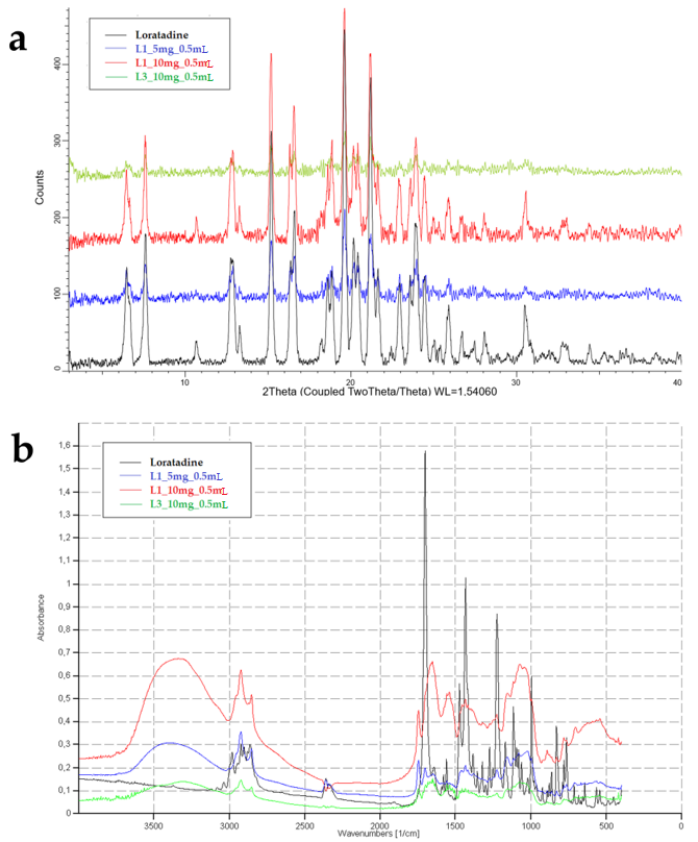
Figure 8. XRPD diffractograms ( a ) and FT-IR spectra ( b ) of raw loratadine and OL